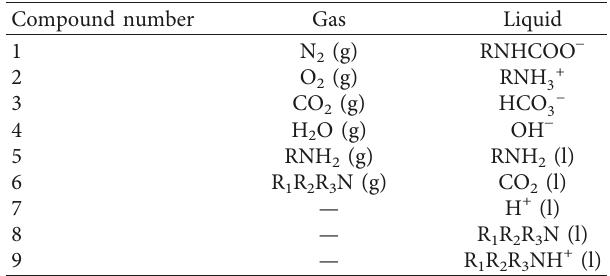
Table 2: Typical values for CO